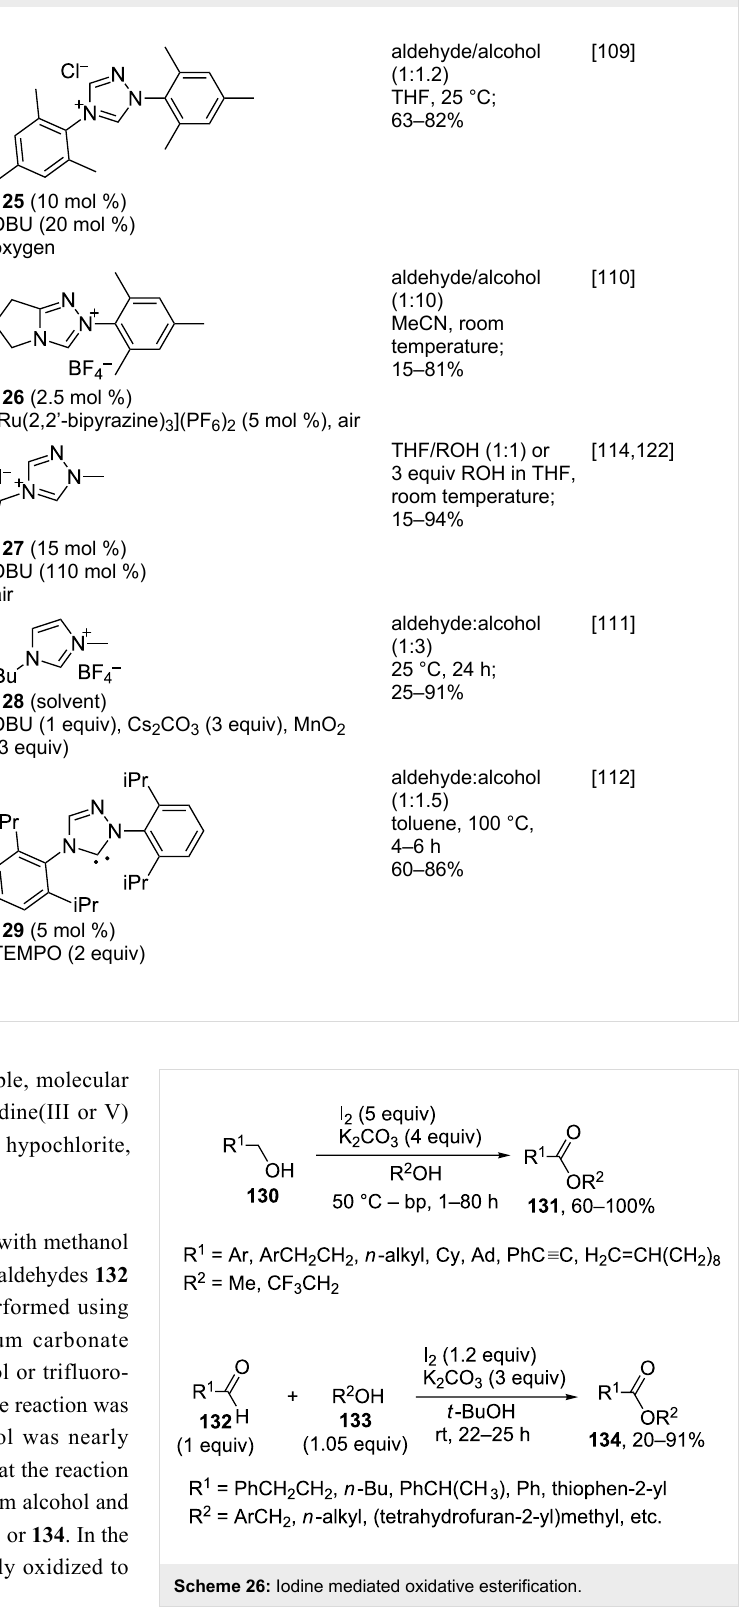
Table 3: Oxidative esterification of aldehydes with alcohols. (continued)